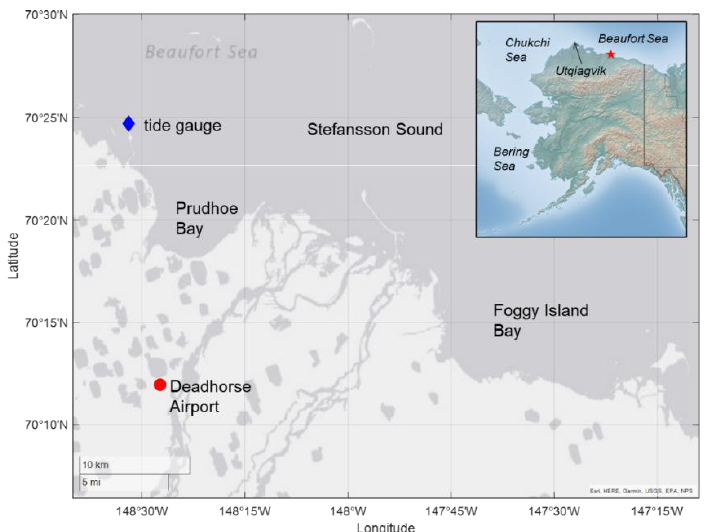
Figure 1. Map showing the Foggy Island Bay focus region along with the locations of the tide gauge (blue diamond) in Prudhoe Bay and the Deadhorse Airport weather station (red dot). The star in the inset map shows the location of the study region in northern Alaska.